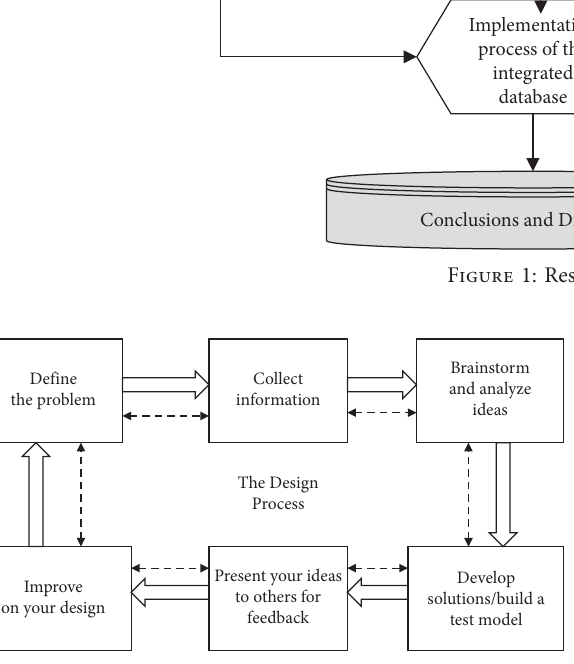
Figure 2: Design process.